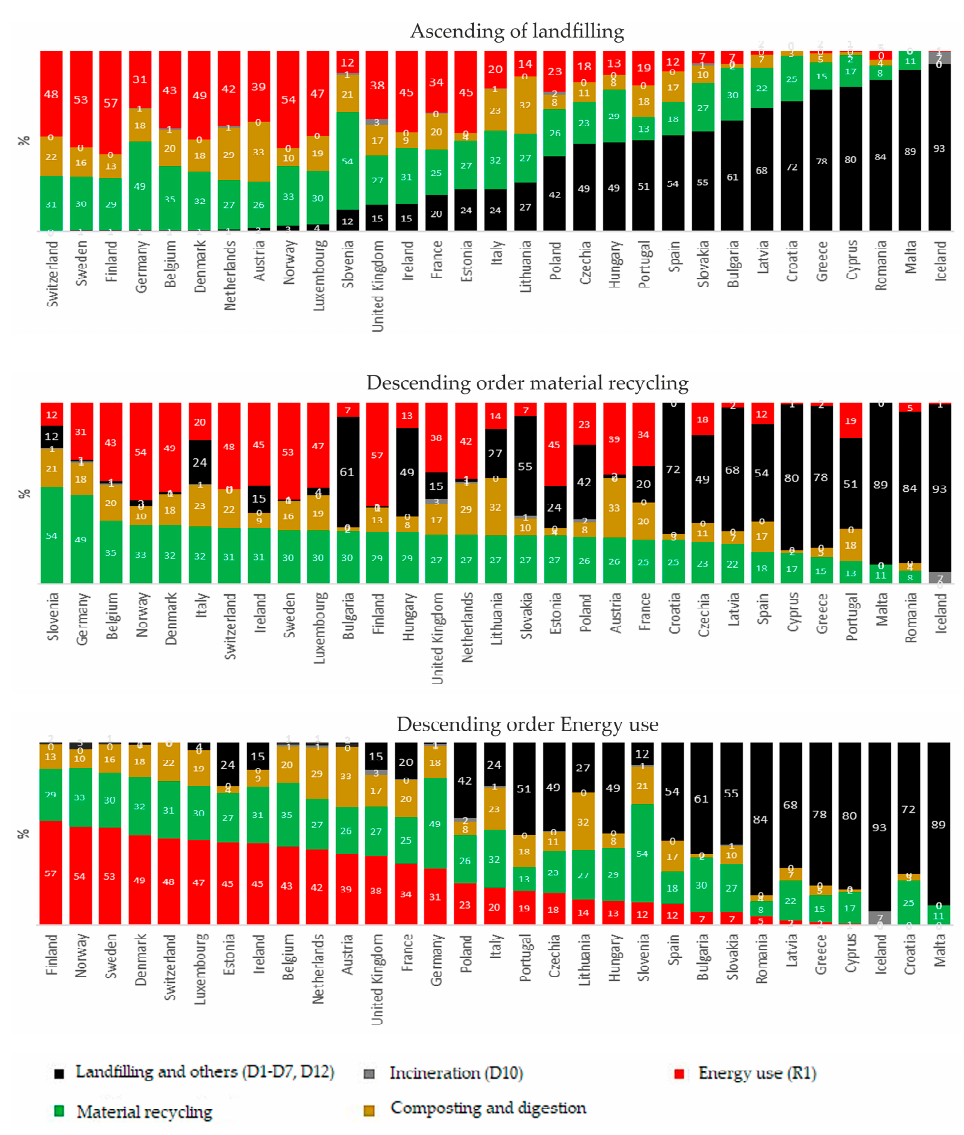
Figure 6. Ranking of countries by waste treatment process in 2018. Table 2. Top 10 EU countries in 2011 by waste hierarchy.